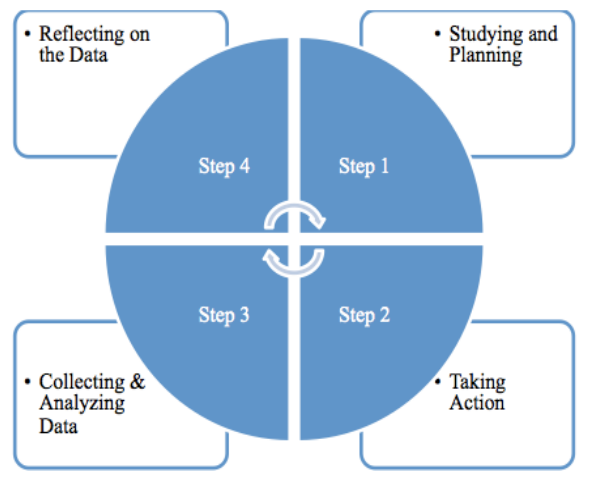
Figure 2. Representation of the Action Research